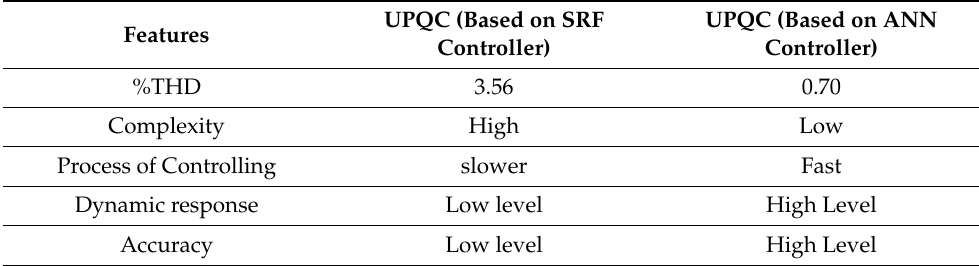
Table 3. Comparison between SRF based controller and ANN based